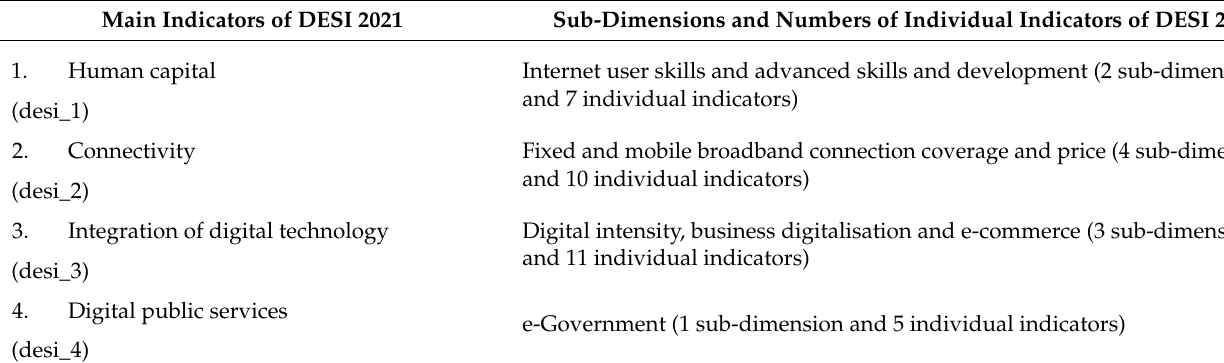
Table 1. Digital Economy and Society Index (DESI) main indicators, sub-dimensions and individual indi-